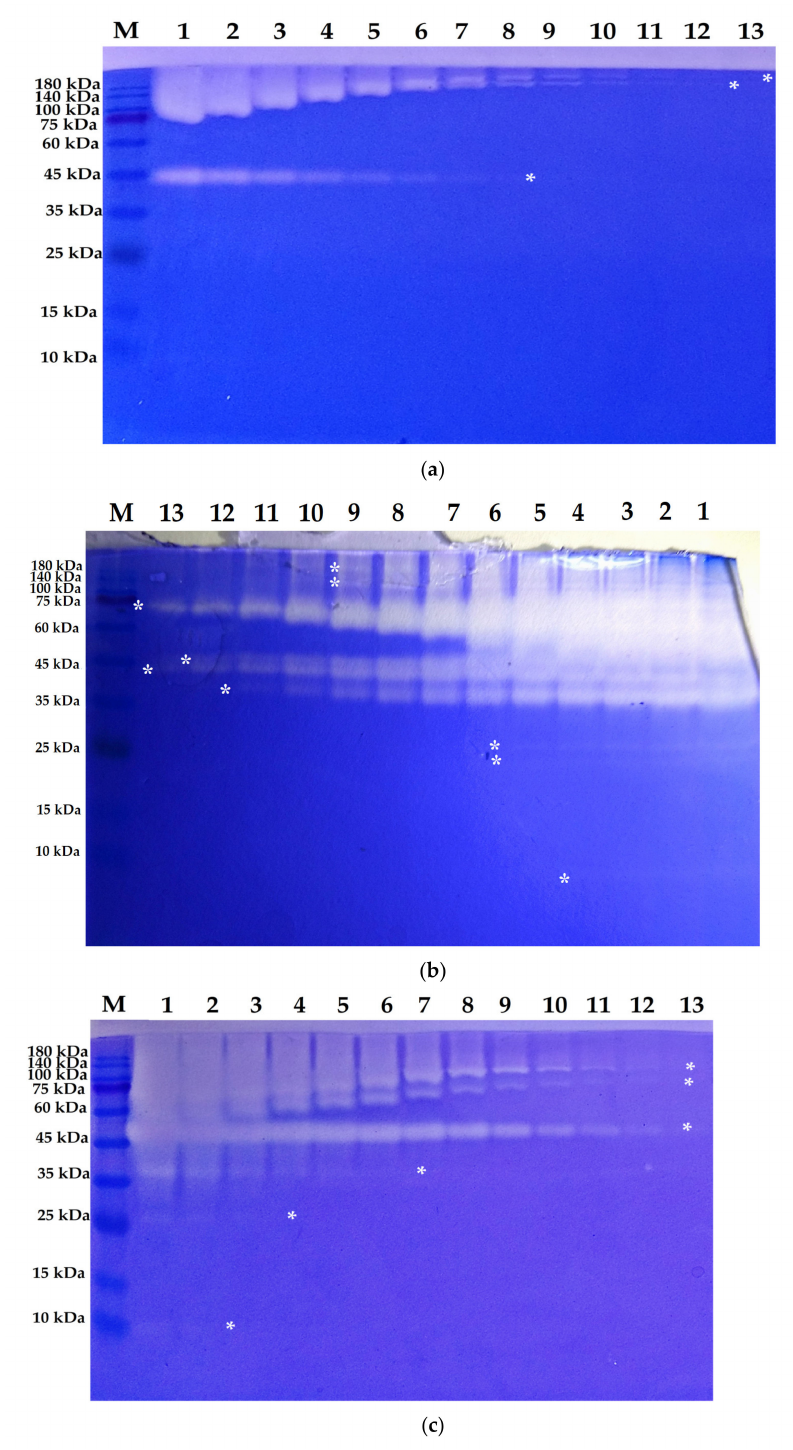
Figure 3. Detection of proteases in tuna head powder (THP) medium using casein ( a ), gelatin ( b ), and THP ( c ). 1–13, twofold serial dilution of the TKU048 crude enzyme. M, protein markers; *, activity